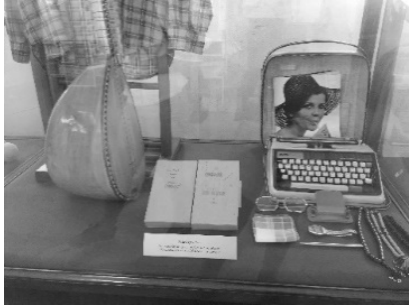
Figure 15. Personal belongings of inmates at the Ulucanlar Museum.